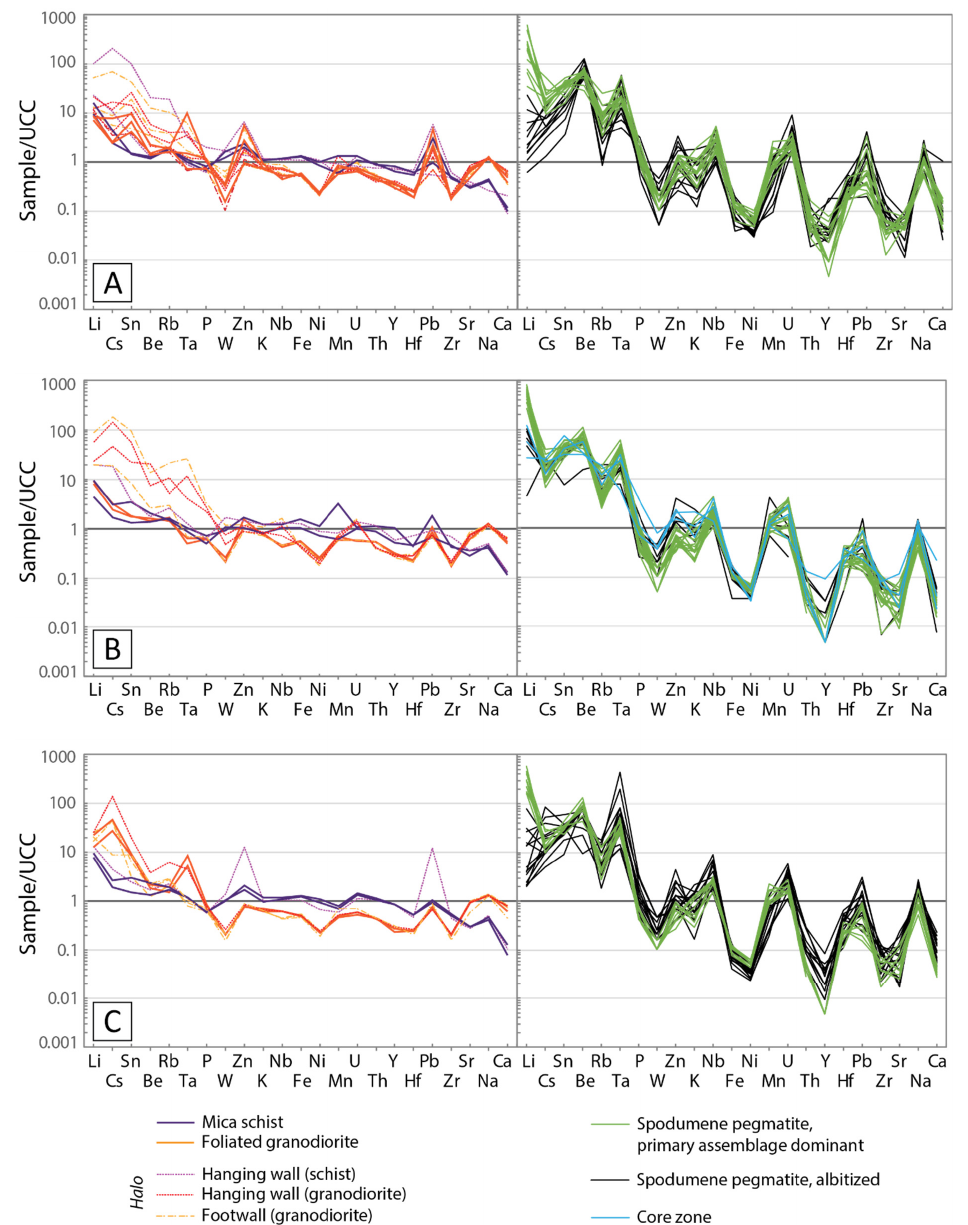
Figure 6. Whole-rock concentrations of elements of interest normalized against the upper continental crust (UCC; values from [34]) for the Aclare drill cores ( A ) ACL 13-02, ( B ) ACL 13-04 and ( C ) ACL 13-05.